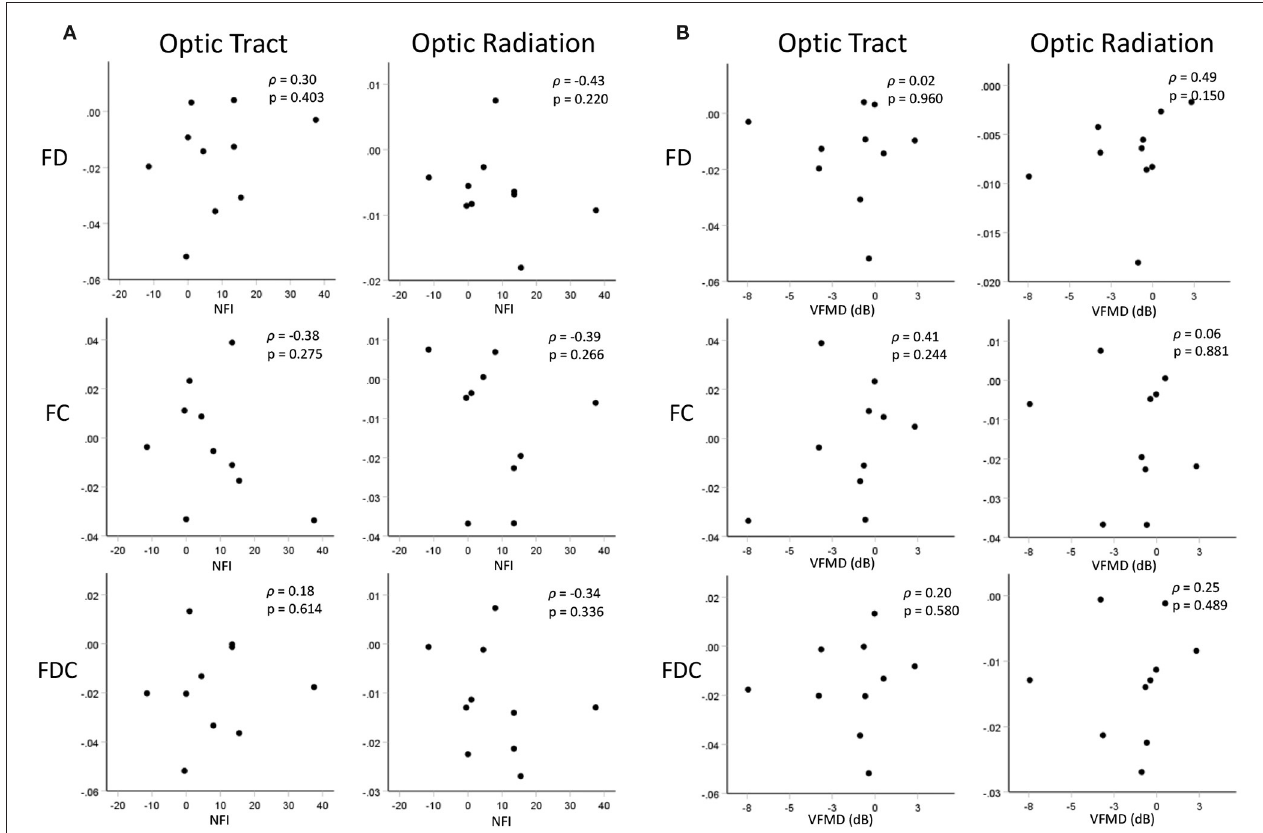
FIGURE 5 | Scatterplots showing correlations between changes in FBA measures of the OTs and ORs and changes in (A) RNFL thickness (represented by NFI) and (B) visual function (represented by VDMD) over time. Displayed FBA, NFI, and VMFD values are the differences in the measures between the two